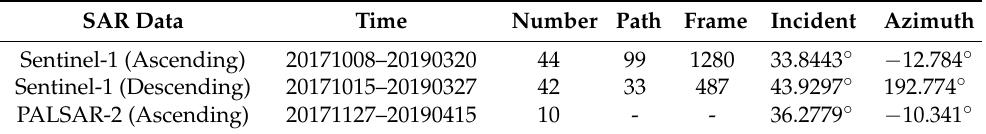
Table 2. Detail parameters of SAR images.